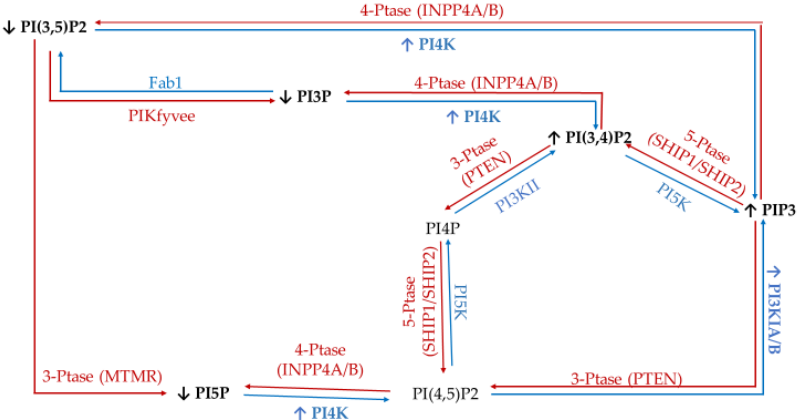
Figure 5. HER2 + related expression of PI kinases and phosphatases. Graphical representation of the cancer specific overexpression / increased activity ( ↑ ) and decreased expression / activity ( ↓ ) of the kinases (blue), phosphatases (red), as well as the hypothesized effects on the resulting lipidome have been noted.